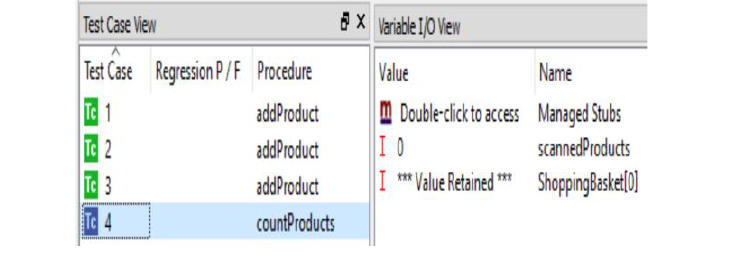
Fig. 7. Test Case Input / Output view